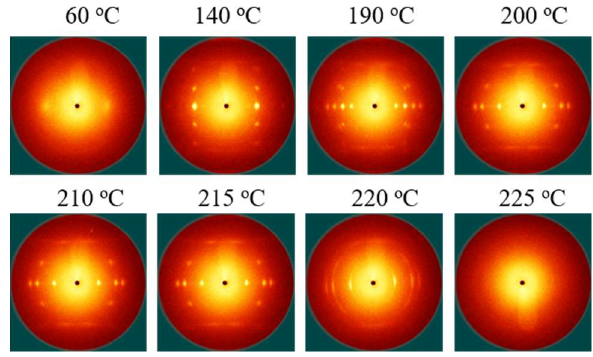
Figure 4. Selected 2D WAXS patterns of PLLA/PDLA-60-2 fiber during the heating process.